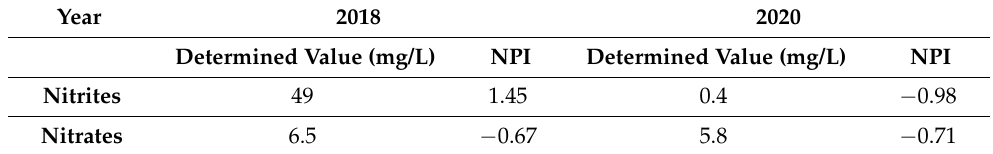
Table 1. Determinations of nitrites, nitrates, and NPI values for Lake Rotund.